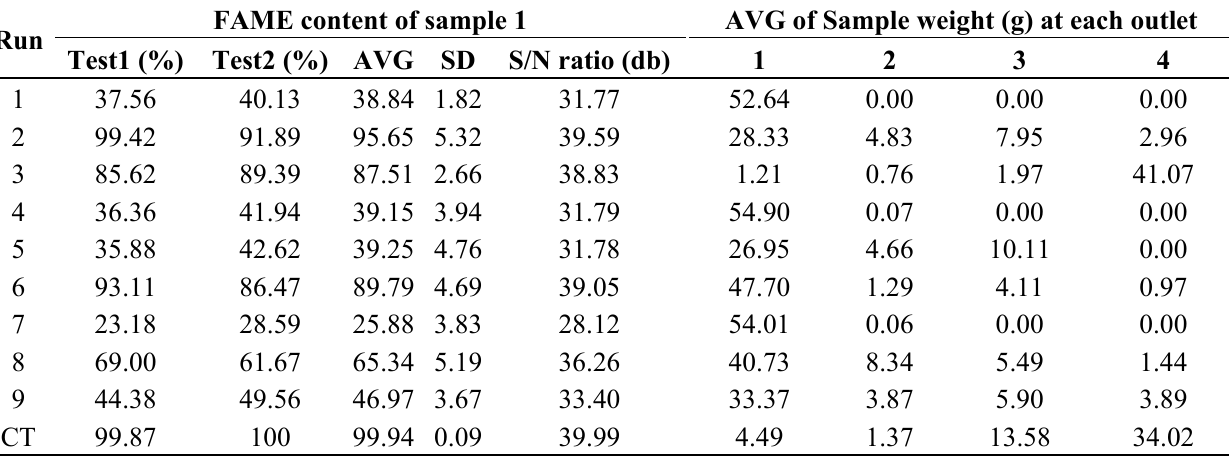
Table 3. Results of L9 (34) orthogonal array experiments on fatty acid methyl ester (FAME) and weight of biodiesel fractionation samples.